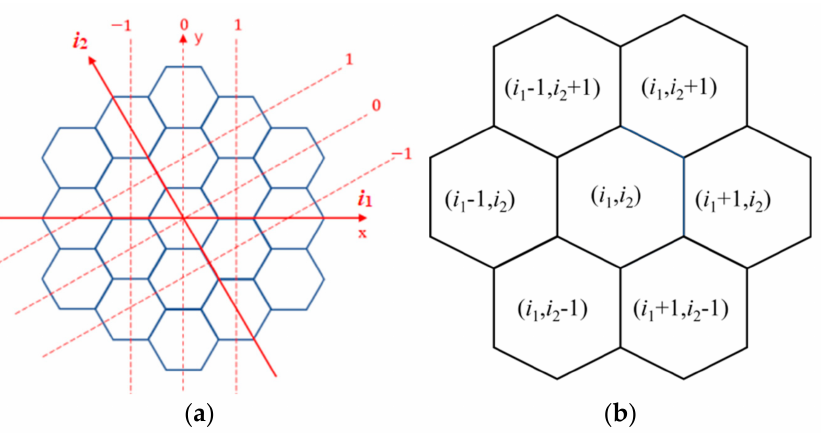
Figure 4. The ( i 1 ,i 2 ) coordinate method used to calculate the process number of the neighboring assemblies: ( a ) ( i 1 ,i 2 ) coordinates; ( b ) neighbor coordinates in coordinates ( i 1 ,i 2 ) .